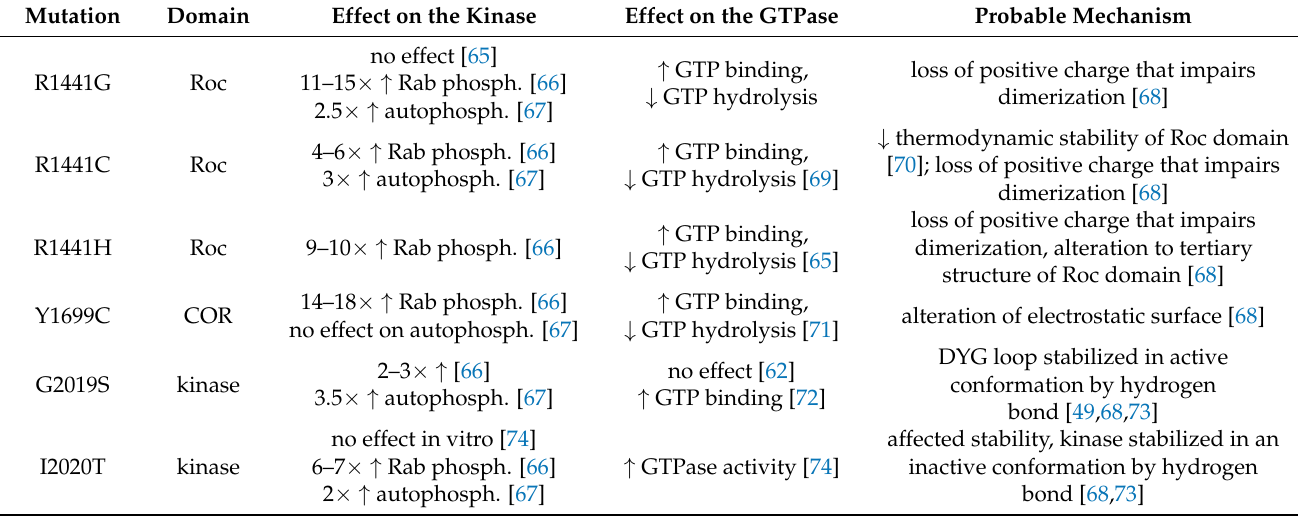
Table 1. Most common, PD-causing LRRK2 mutations and their effect on the protein activity.